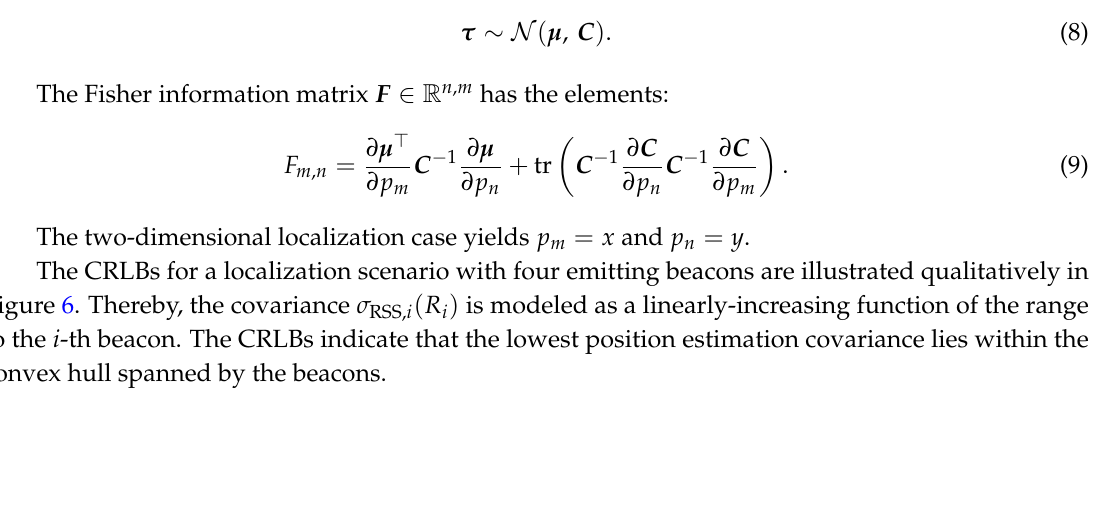
Figure 5. Identification of two beacons transmitting at 432.6MHz and 433.0MHz, respectively. The receiver unit identifies the beacons and corresponding RSS values by determining the frequencies and peak values.